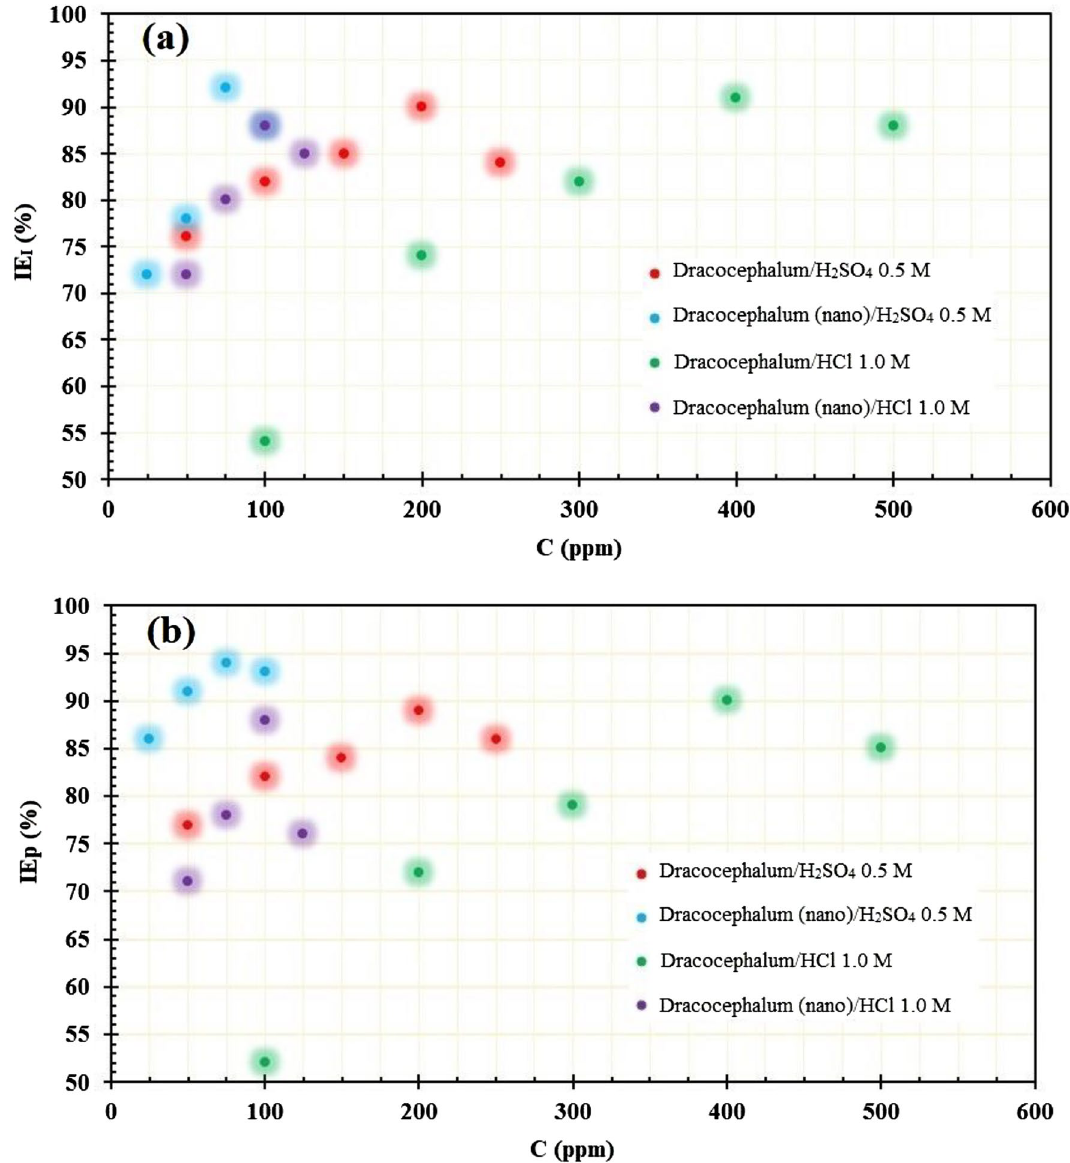
Figure 7. Variation of IE % with the concentration of inhibitor for both ( a ) impedance, and ( b ) polarization